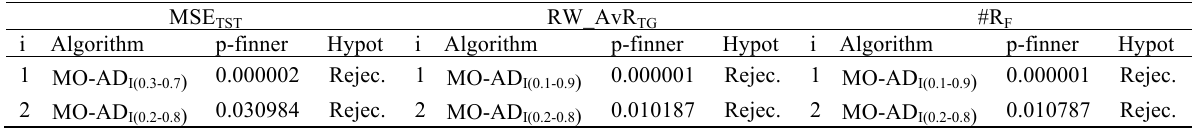
Table A.12 Finner Table with α = 0.05 for the methods on MSE TST , R W _AvR TG and #R F measures on MEDIAN